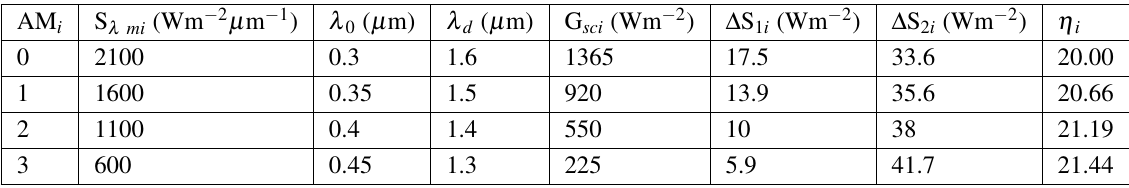
Table 2. The values of the efficiencies obtained from Eq. (10) based on the suggested